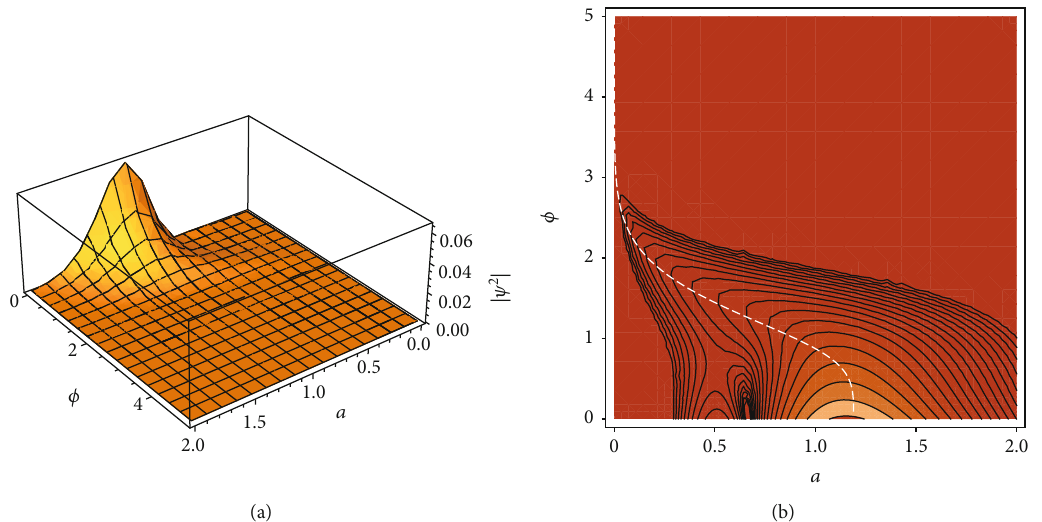
Figure 5: The fi gures show the square of the wave function (a) and its corresponding contour plot (b). Also, the dashed line denotes the classical trajectory of the system in the plane a − ϕ . The fi gures are plotted for the numerical values: g σ = 1/2 , and w = 3 0